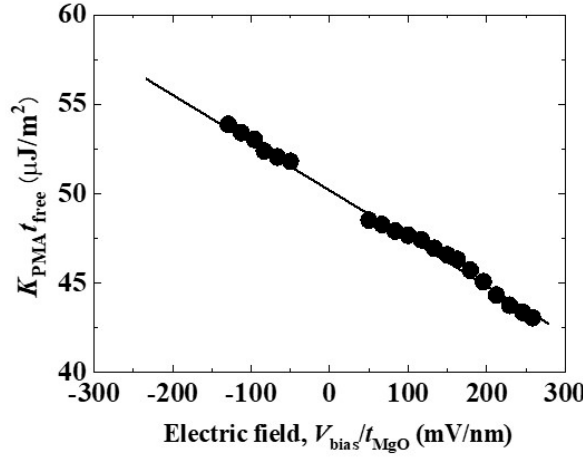
Figure 3. Example of applied electric-field dependence of K PMA t free observed in an MgO-based MTJ structure. Reprinted figure with permission from [48], Copyright 2010 by the AIP Publishing LLC.